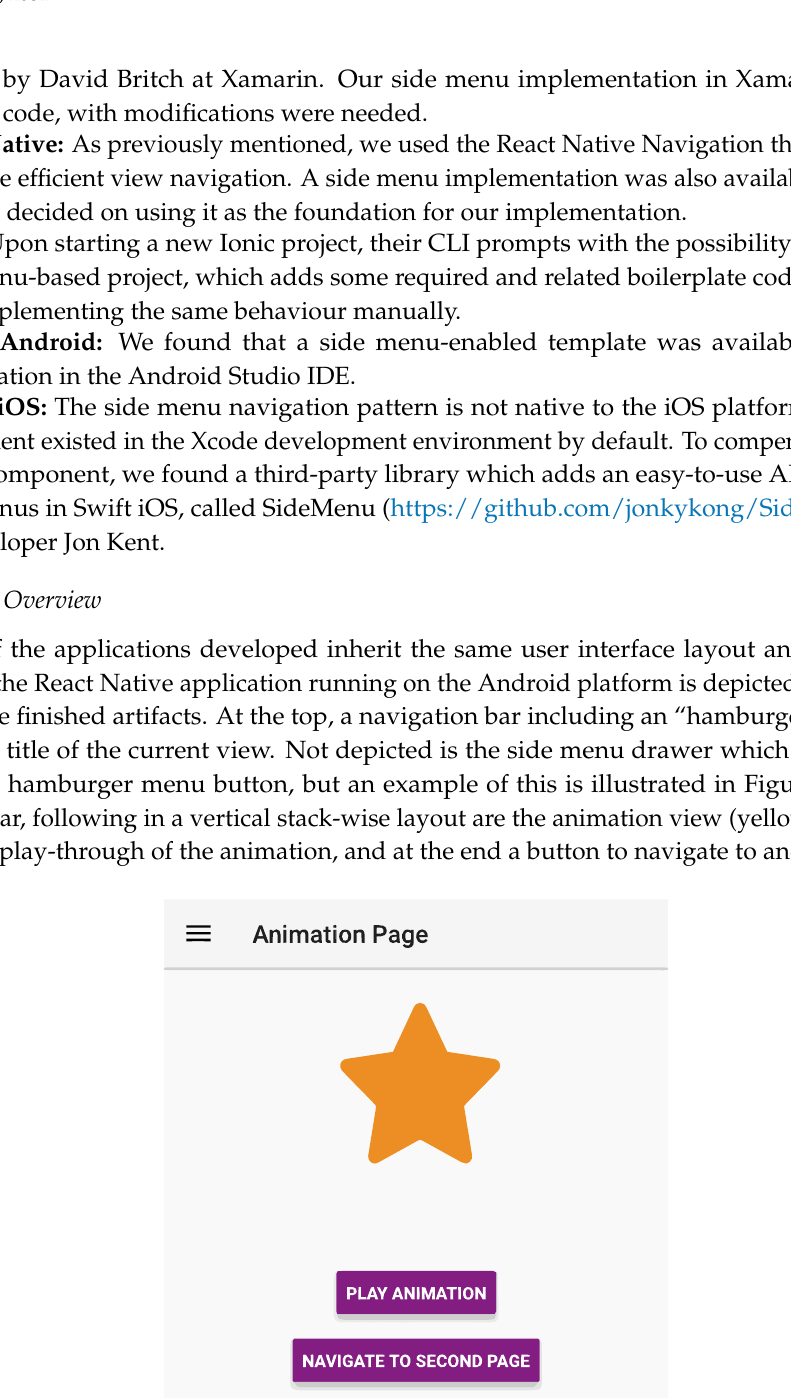
Figure 3. Cropped example of a developed